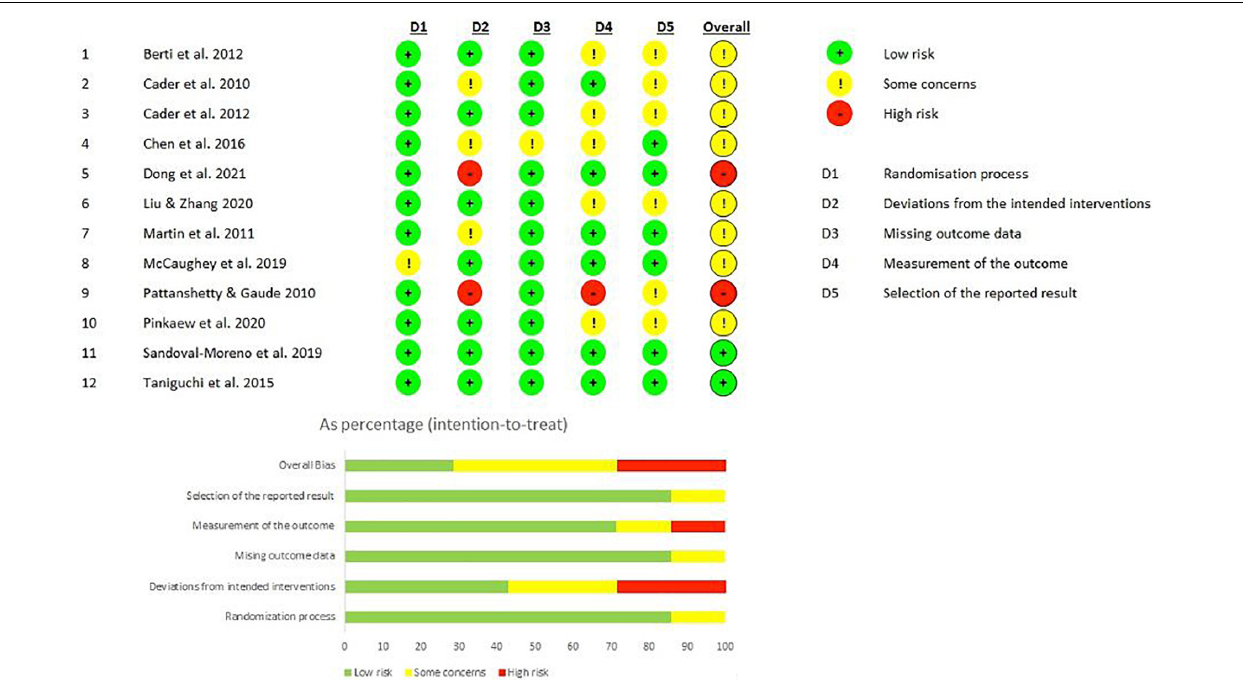
FIGURE 3 | Risk of bias of the included studies according to the